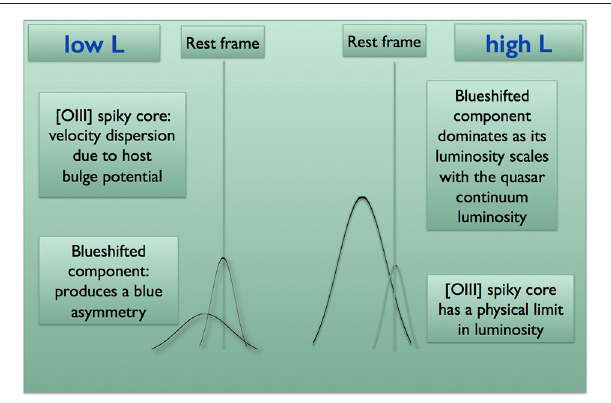
FIGURE 2 | The high prevalence of large [OIII] λλ 4959,5007 blueshift at high L explained as a luminosity effect. The luminosity of the blue shifted component grows with the nuclear continuum luminosity, dominating the total [OIII] emission in very luminous quasars. Figure 6 of Marziani et al. (2016b) shows the same same effect in terms of EW: the EW of the core component is lower in very luminous sources because of the strong nuclear continuum, while the EW of the blue shifted component remains